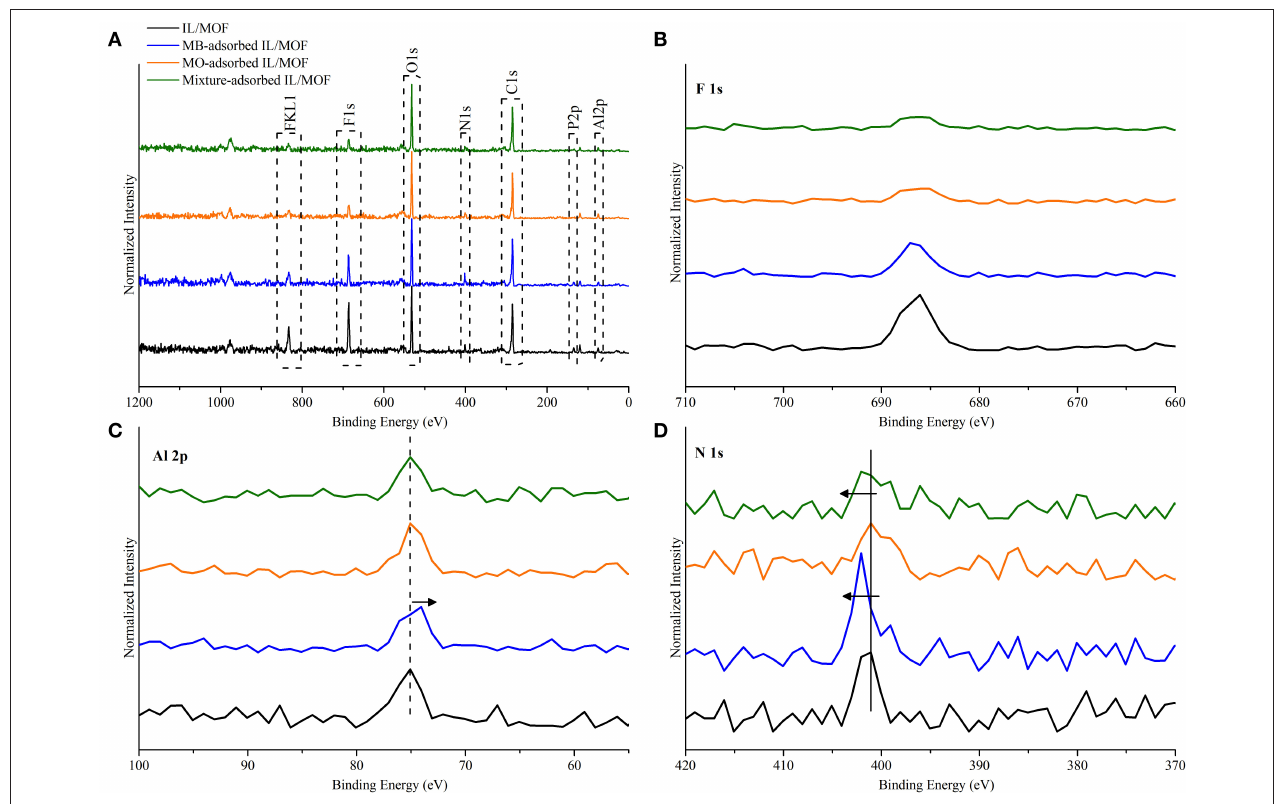
FIGURE 10 | XP spectra of (A) IL/MOF composite and IL/MOF composite after the adsorptions of MB, MO, and their mixture; (B) F 1s; (C) Al 2p; and (D) N 1s. XP, X-ray photoelectron; IL, ionic liquid; MOF, metal–organic framework; MB, methylene blue; MO, methyl